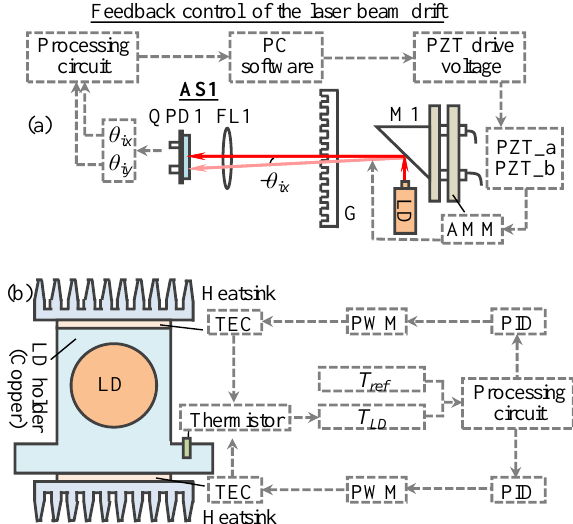
Figure 4. Principle of the real-time wavelength stabilizer: ( a ) method Ⅰ compensation of laser beam drift, ( b ) method Ⅱ automatic temperature control of laser diode.